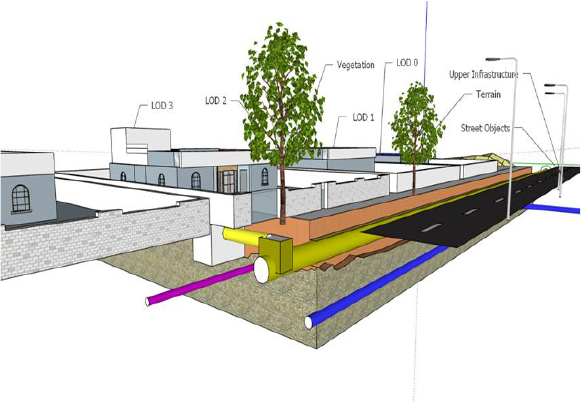
Figure 2 . The complexity of urban infrastructure in Oman.